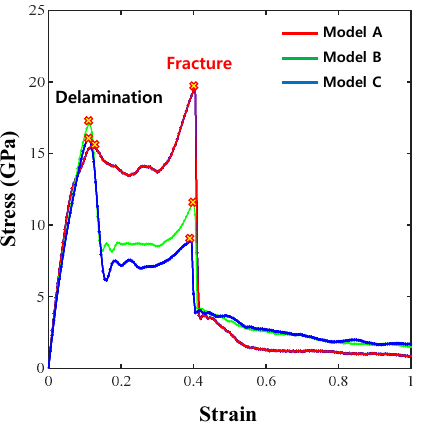
Figure 4. Zigzag direction σ– ε results for models A, B, and C.